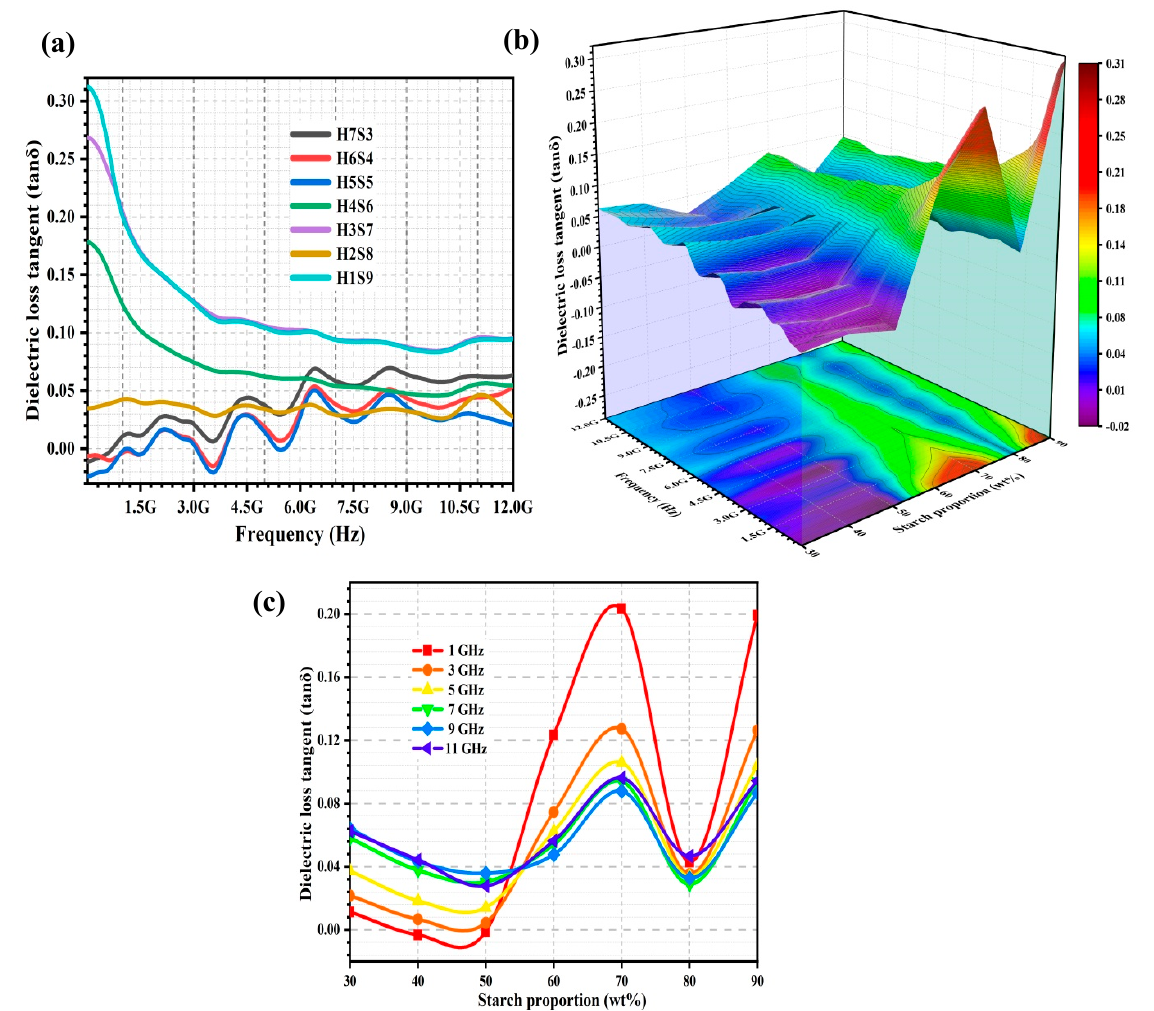
Figure 5. The tan δ spectra ( a ) of the porous nHA/S composites. Three-dimensional representation of tan δ values of the porous nHA/S composites ( b ). The tan δ curves of the porous nHA/S composites at varied selected frequencies ( c ).